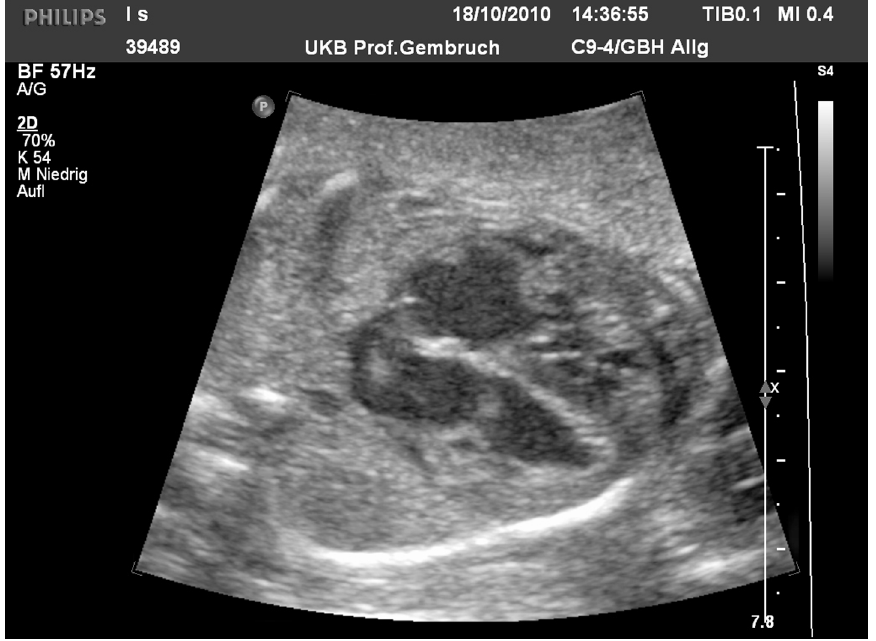
Figure 1. Cardiac findings in urinary tract malformation. Biventricular myocardial hypertrophy in a fetus with bilateral renal agenesis at 21 weeks of gestation.